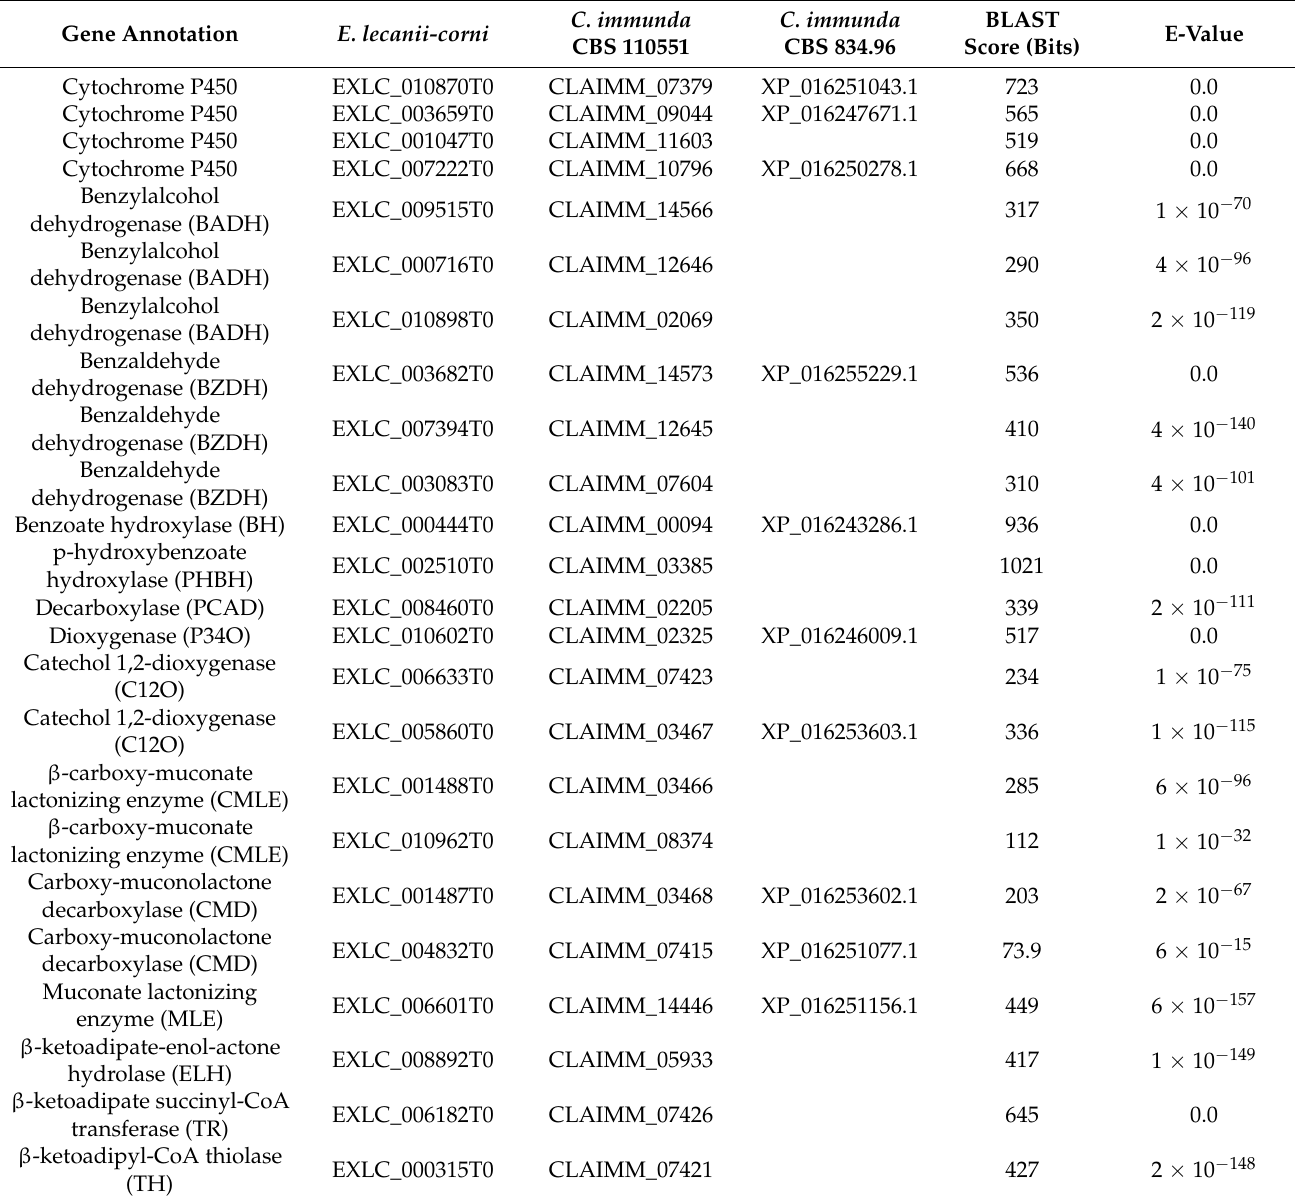
Table 3. Toluene degradation pathway genes present in the genome of E. lecanii-corni relative to C. immunda . Gene